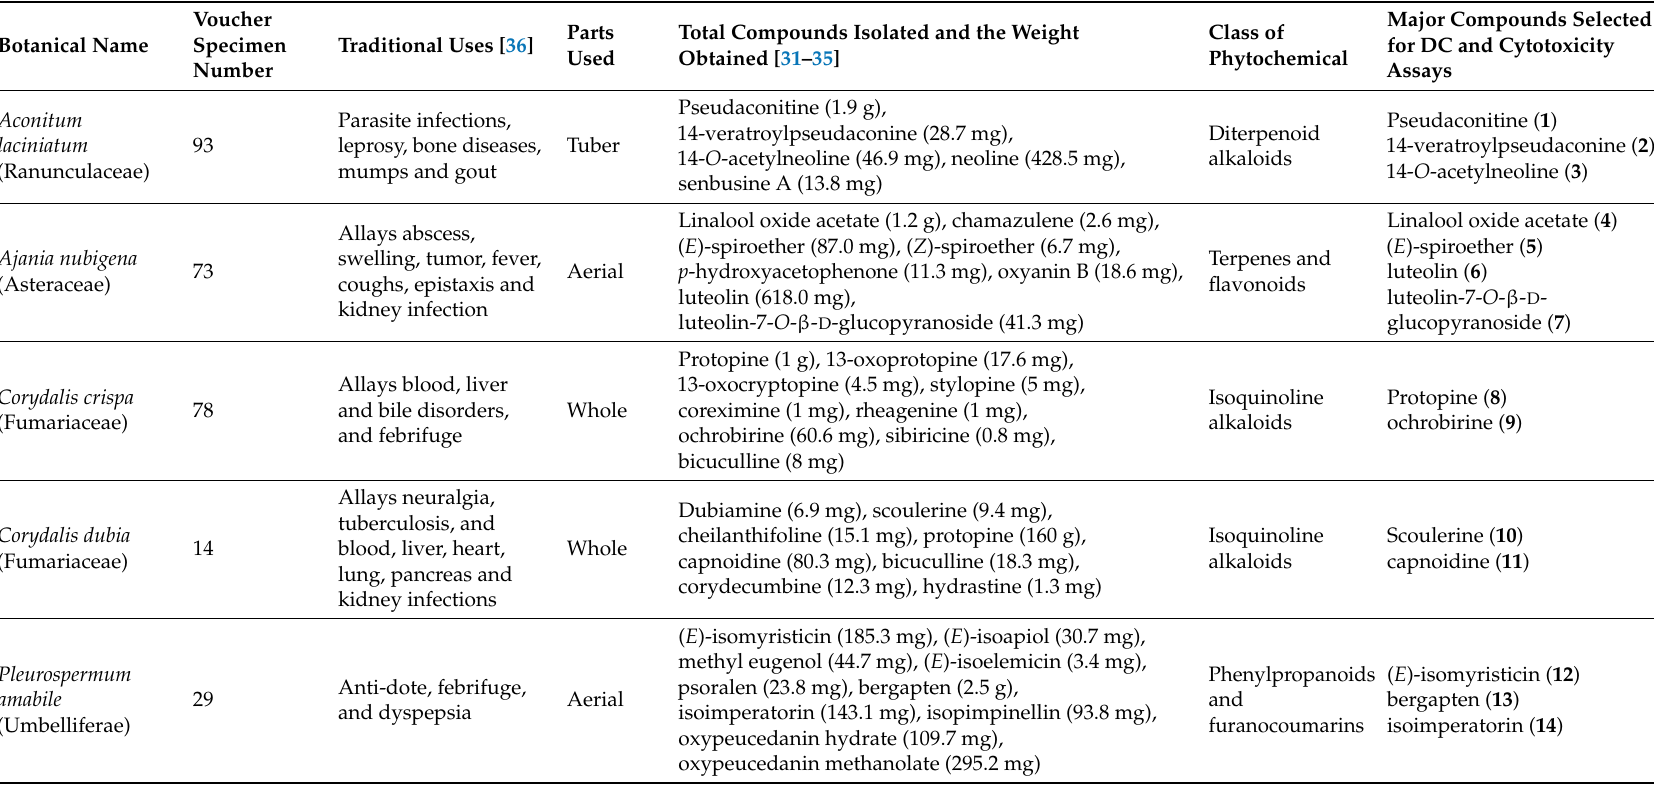
Table 1. Five medicinal plants and the selected compounds screened for immunomodulatory bioactivity in DC2.4 murine dendritic cell line and cytotoxicity in immortalized non-cancerous H69 human cholangiocyte cell